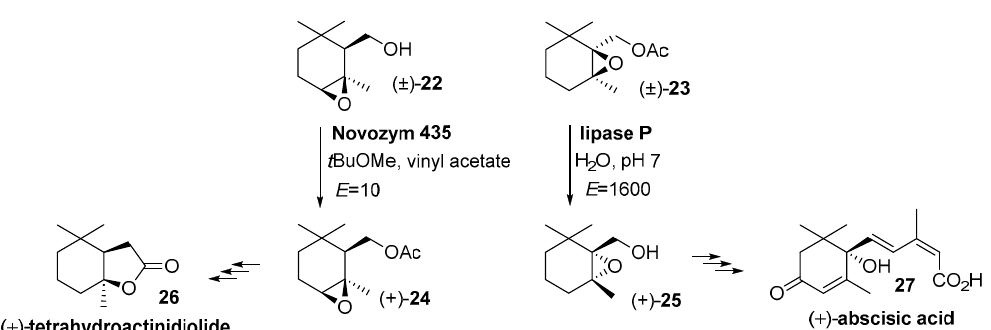
Figure 5. The lipase-mediated resolution of the two substituted epoxy-cyclohexylmethanol regioisomers, 22 and 23 . Chiral building blocks 24 and 25 was used for the synthesis of the flavor tetrahydroactinidiolide 26 and the vegetal hormone 27 , respectively.